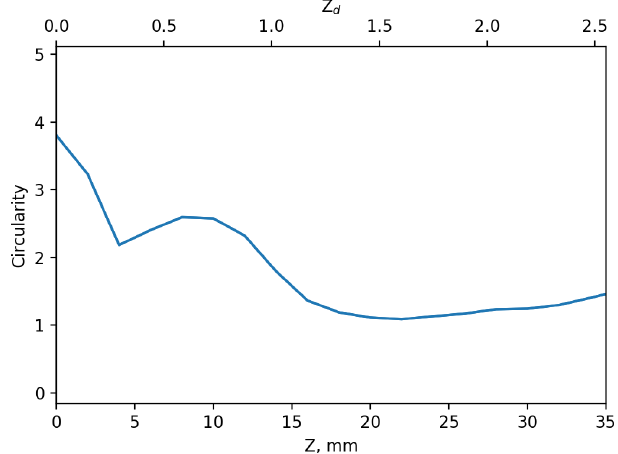
Figure 11. The circularity (Eq. 4) of the rosette shown in Fig. 3 as a function of distance from the object plane Z and Z d